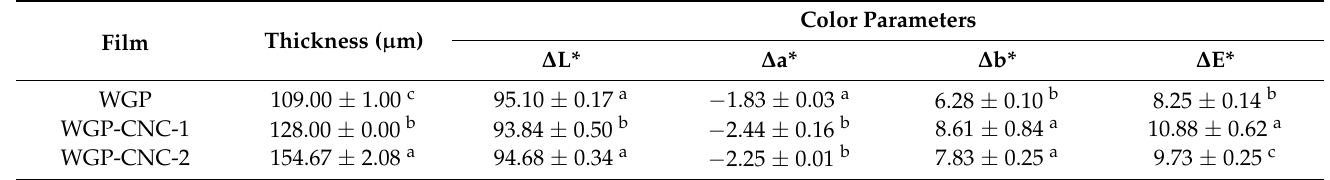
Table 3. The thickness and color parameters of WGP-based films with different adding amounts of CNC (CNC-1: 0.25%; CNC-2: 5%). Different letters (a–c) in the same column indicated